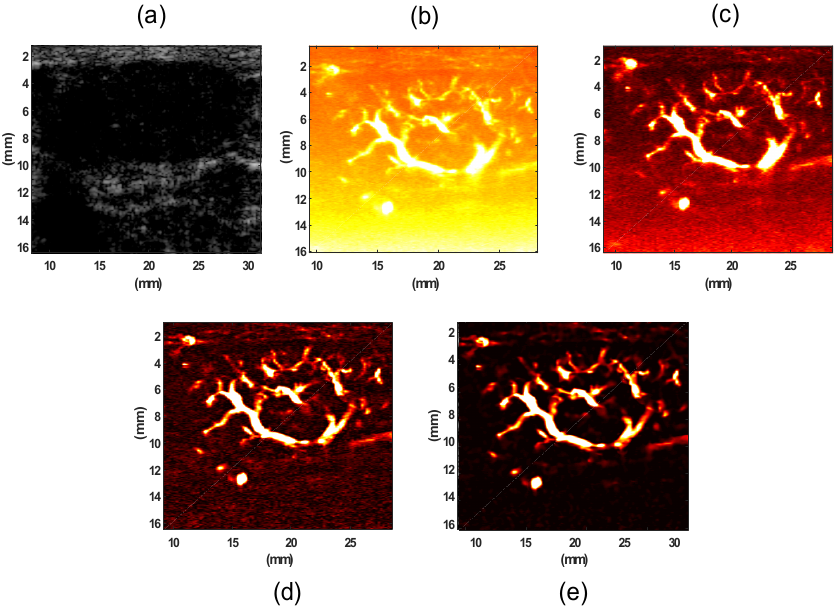
Figure 3. ( a ) B-mode image of a benign breast fibroadenoma (hypoechoic regions), ( b ) gross vasculature image using SVD, ( c ) vasculature image after unbiased SVD, ( d ) vasculature image using SVD + TH filtering (SVD+THF) filters, ( e ) final image of the vasculature after applying the proposed method (NLM+TH).